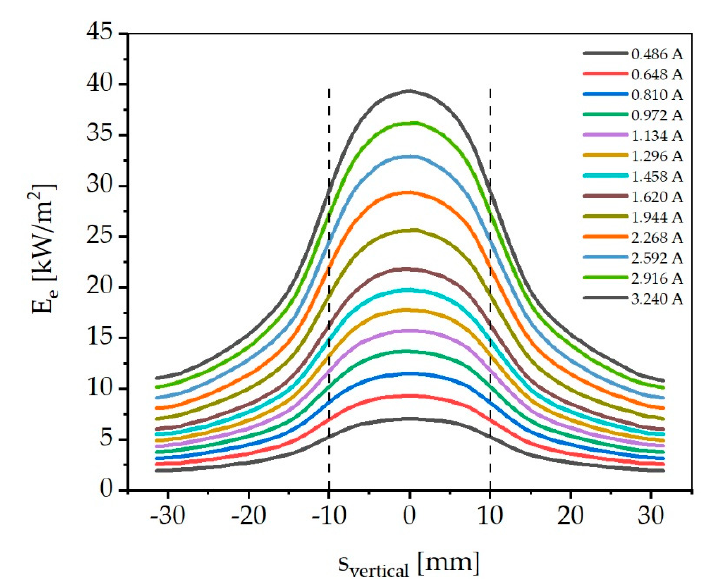
Figure 7. Vertical sections through the irradiance distribution on the virtual detector of the raytracing simulation. The area between the dashed lines marks the position of a centered sample.